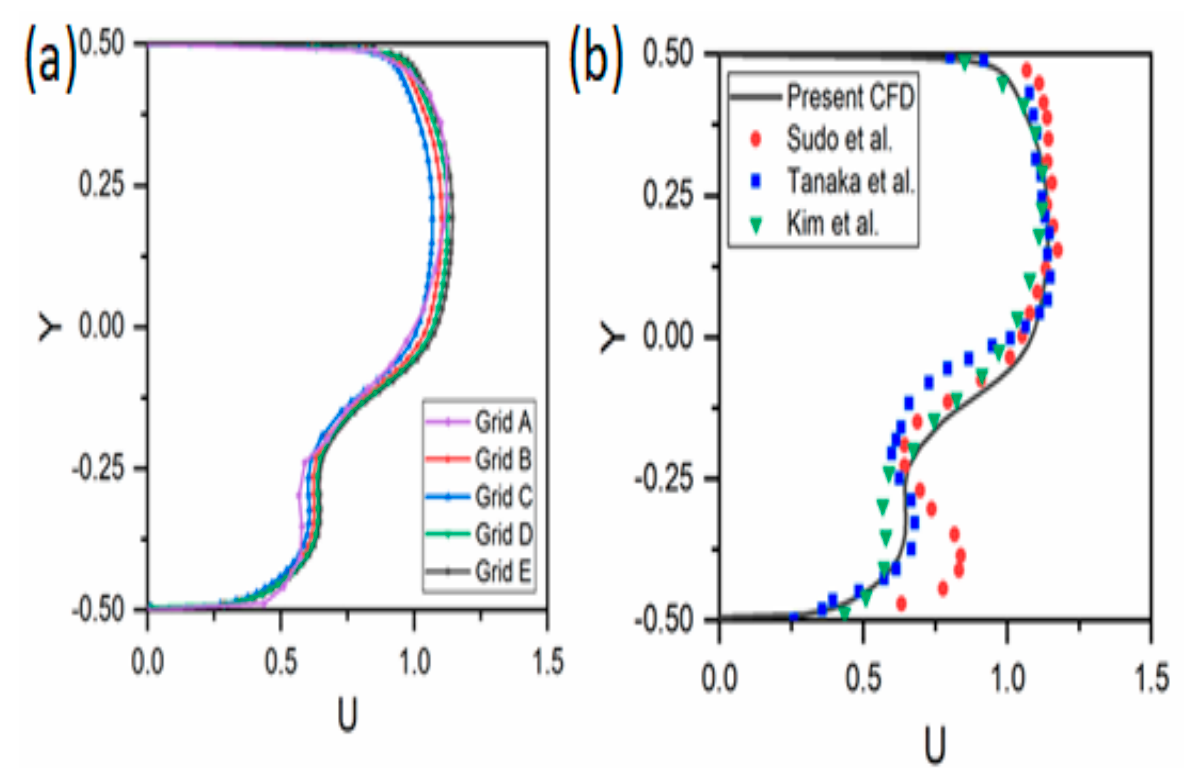
Figure 2. Assessment of normalized axial velocity profile at bend outlet ( a ) grid convergence test ( b ) validation of the present CFD model.